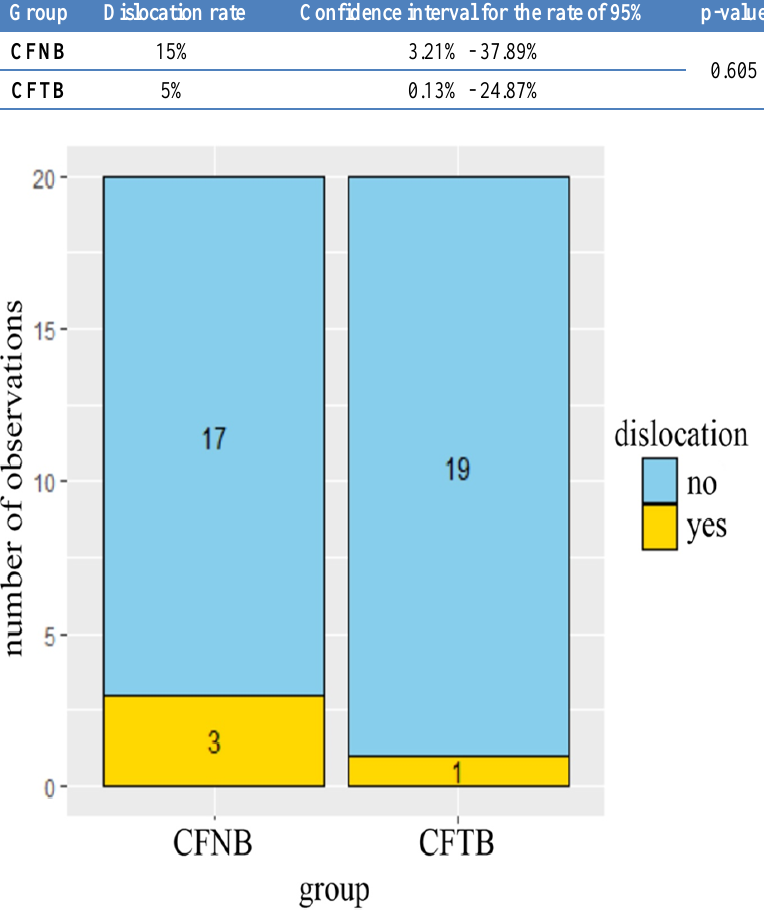
Figure 3. Dislocation rates of the catheter in particular